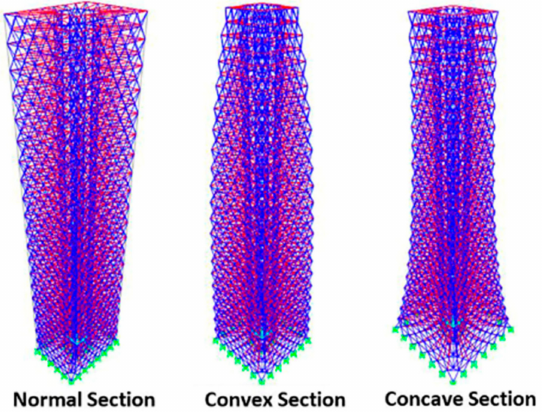
Figure 12. Diagrid structures with vertical, convex and concave façades. Used with permission of Taylor & Francis Ltd. (www.tandfonline.com), from Ardekani et al.